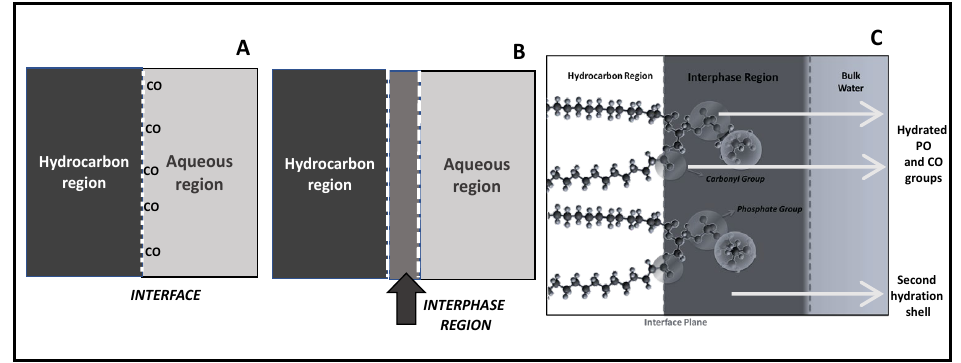
Figure 1. Different schematical descriptions of the interface: ( A ) The Gibbs model, ( B ) The Guggen- heim model and ( C ) The membrane interphase model.